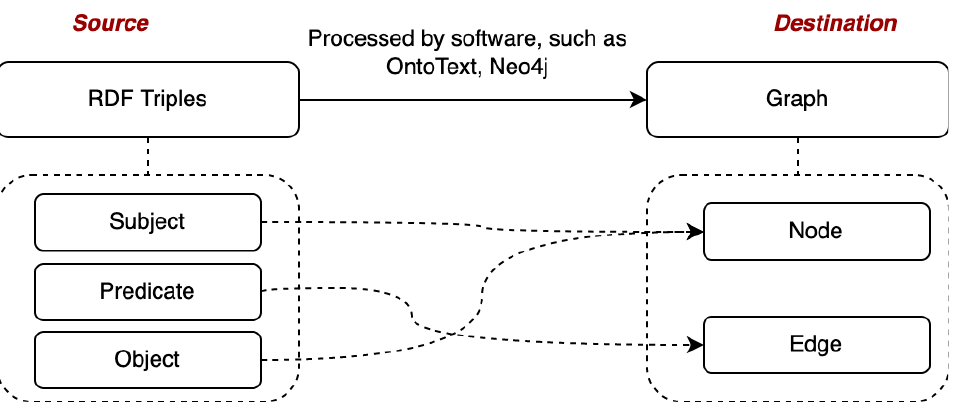
Figure 11. The relationship between RDF and